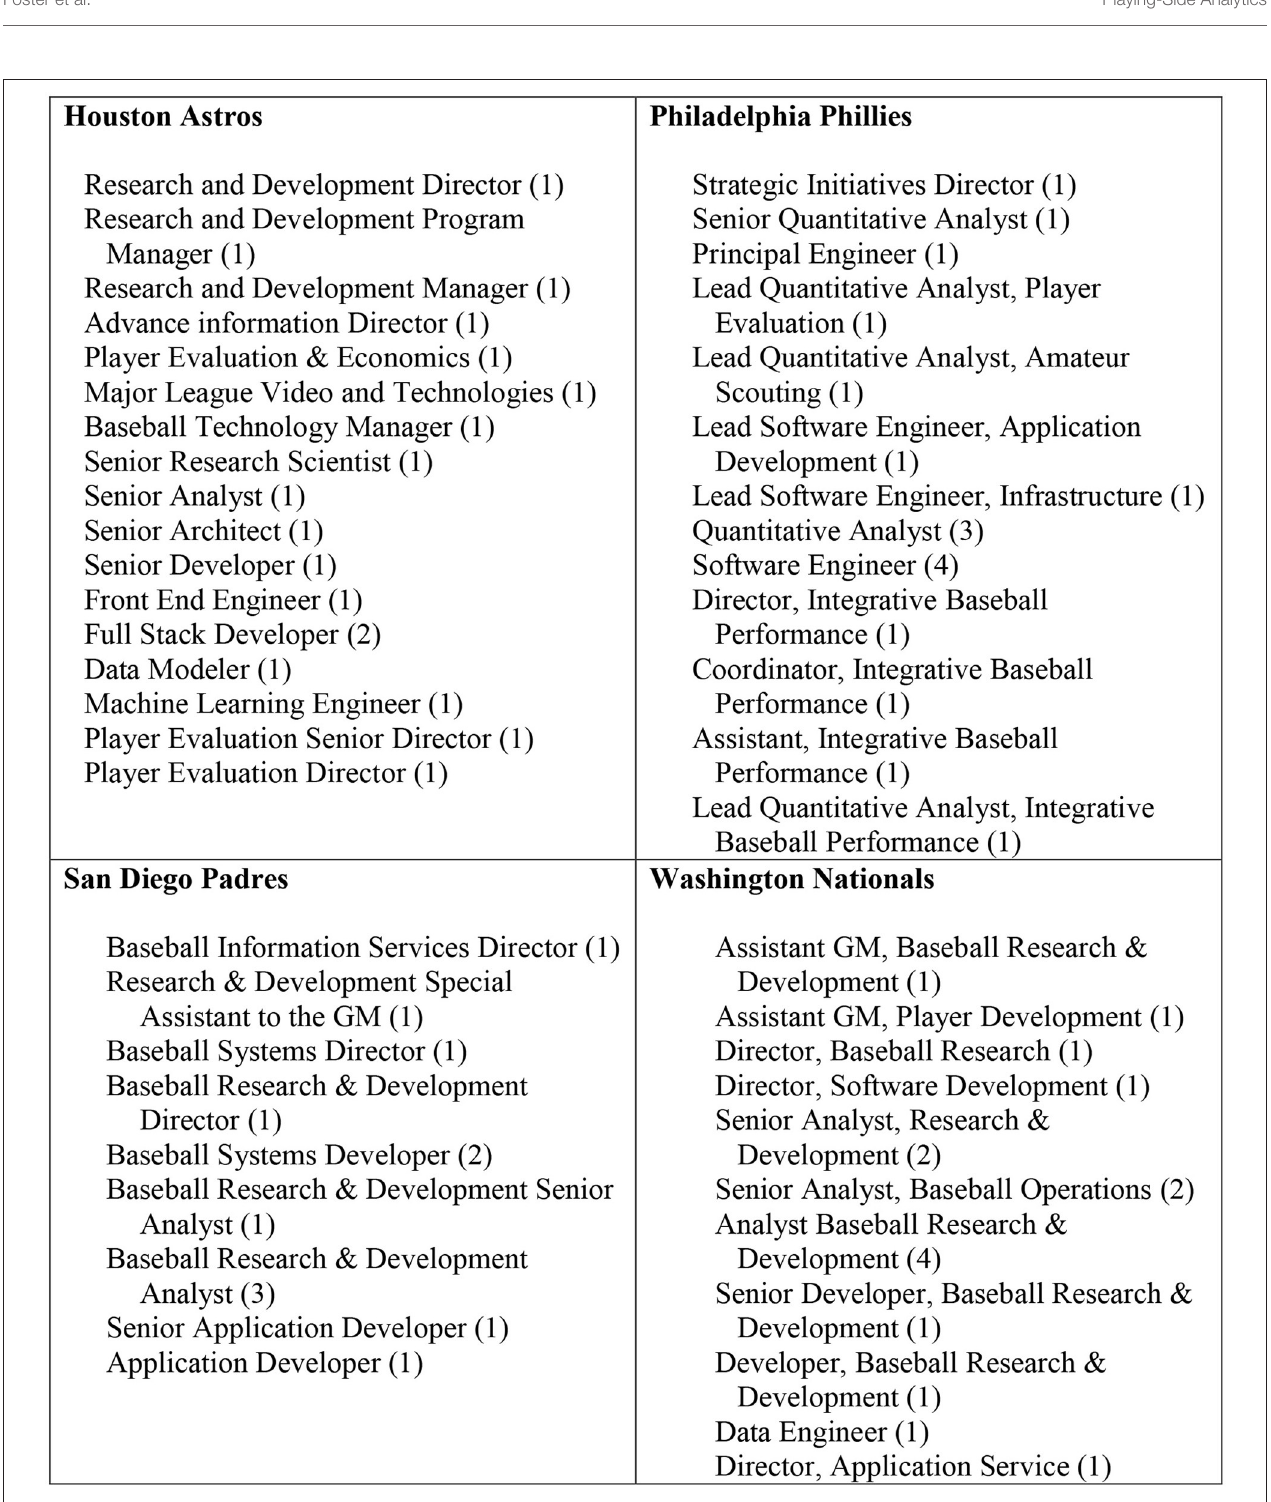
FIGURE 7 | MLB club player-side analytics groups: position descriptors in 2020 media guides of four selected clubs.